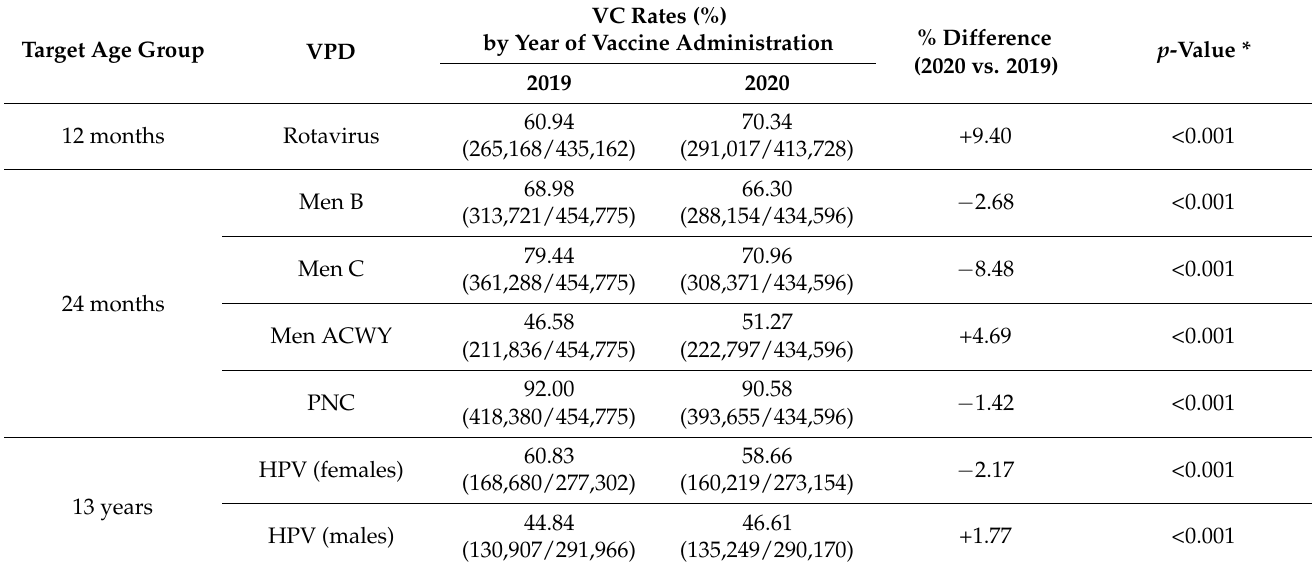
Table 2. National vaccine coverage (VC) rates (%) registered for recommended vaccinations at 12 months, 24 months, and 13 years of age, stratified by vaccine type and year of administration, along with the percentage differences between the 2019 and 2020 rates in